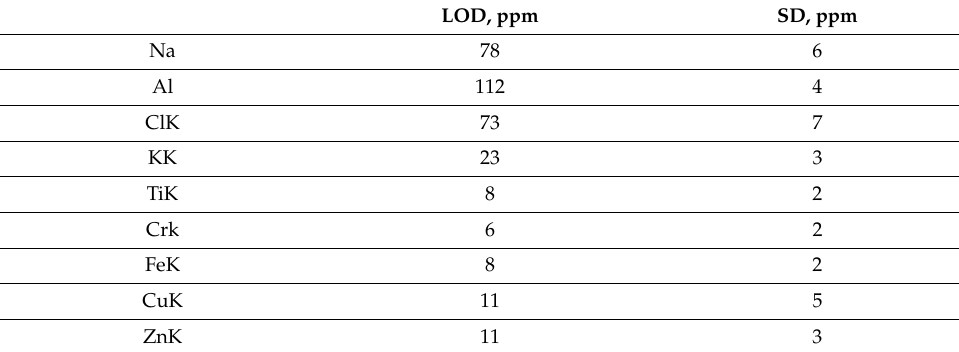
Table 3. Limit of detection for elements analyzed by PIXE in the study.